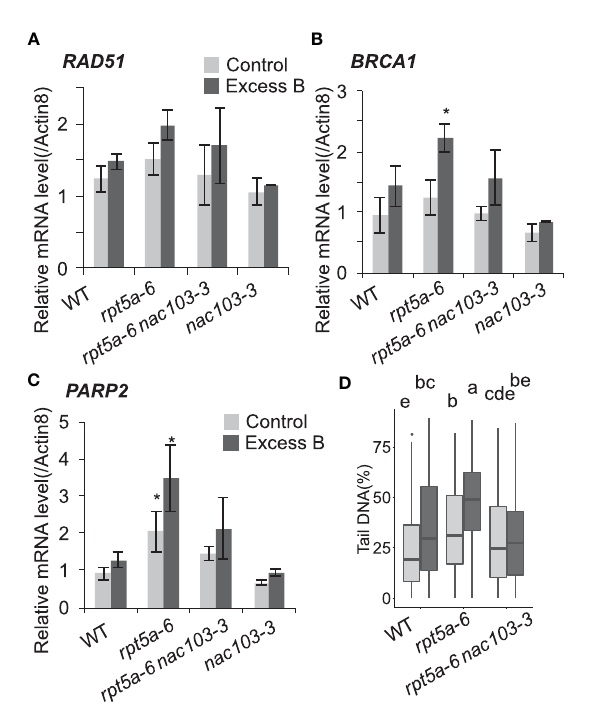
FIGURE 5 nac103-3 mutation suppressed DNA damage accumulation in rpt5a-6 Seedlings were grown for six days under control conditions (30 µM boric acid) and further three days on control or excess boron conditions (3 mM boric acid). (A – C) mRNA accumulation of DNA damage maker genes. Total RNA was extracted from whole root of 10 seedlings and mRNA accumulation was quanti fi ed by qRT-PCR. Expression levels were normalized by Actin8 . Values represent mean ± standard deviation of three biological replicates. Asterisks indicate signi fi cant difference from the wild type in each condition at p < 0.05 by Dunnett ’ s test. (D) Accumulation of DNA damage (double strand break) was quanti fi ed with comet assay neutral method. Seedlings were grown for 6 days under control conditions (30 µM boric acid) and further 3 days on control or excess boron conditions (3 mM boric acid). Nuclei were extracted from 1 cm of root tips of approximately 100 seedlings per each condition. The ratios of DNA in tail were calculated by CASP software. For each condition, 125 nuclei were measured. Groups sharing same letters were not signi fi cantly different by Steel-Dwass test at p <